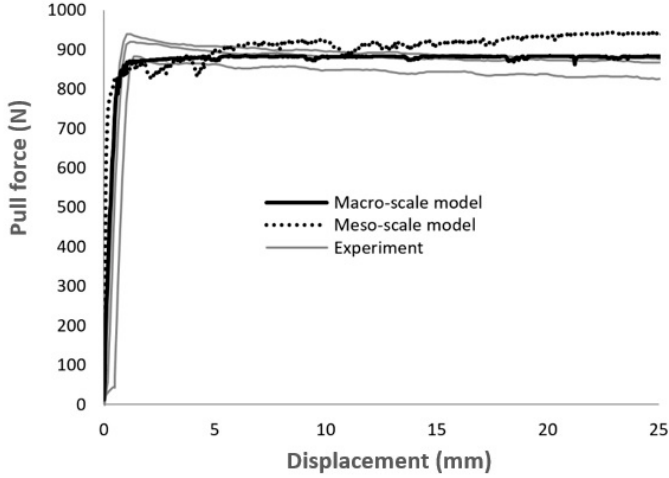
Figure 16. Comparison of displacement-pull force curves between experiments and simulation of friction test for fabric variant 1. Table 4. Computational cost of both macro- and meso-scale models for textile variant 1.